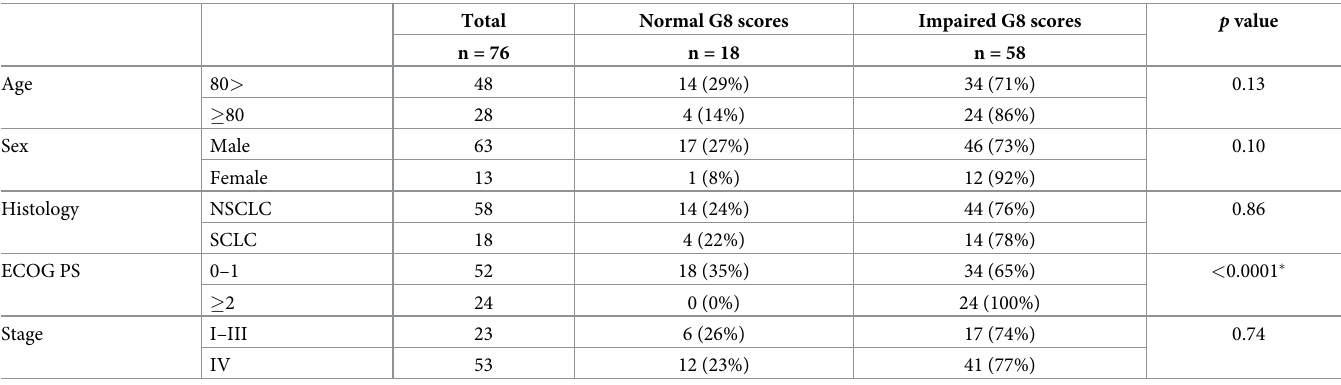
Table 3. G8 scores and patient characteristics in the patients treated with chemotherapy (n =